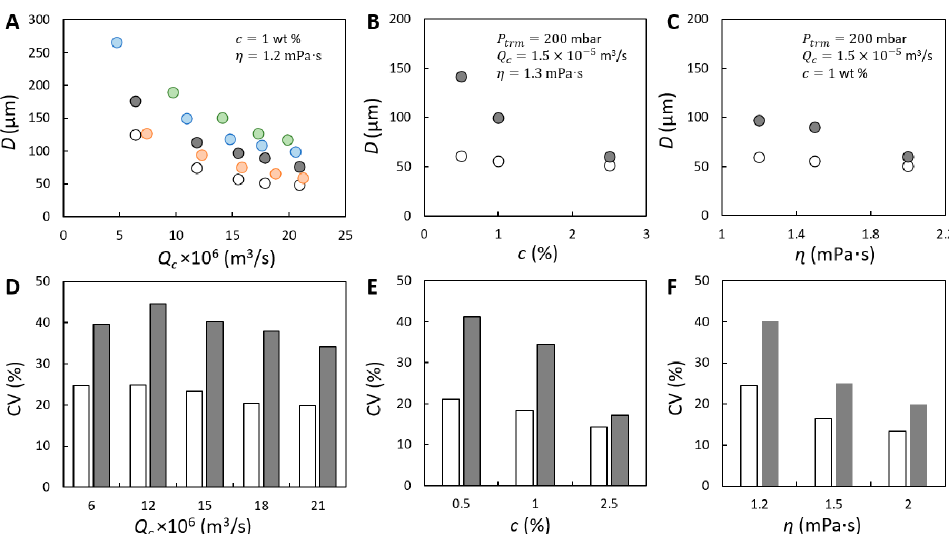
Figure 5. The size and size distribution of coalesced, stabilized bubbles. Bubble size ( 𝐷 (cid:3030)(cid:3042)(cid:3028)(cid:3039) , presented with filled circle) under the effects of: ( A ) shear flow; ( B ) protein concentration; ( C ) continuous phase viscosity. In ( A ), the effect of shear flow on 𝐷 (cid:3030)(cid:3042)(cid:3028)(cid:3039) is investigated for 𝑃 (cid:3047)(cid:3045)(cid:3040) equal to 100 ( ), ), 200 ( ), 300 ( ) and 400 ( ) mbar. In ( A – C ), the size of initial bubbles ( 𝐷 (cid:2868) ) measured at 𝑃 (cid:3047)(cid:3045)(cid:3040) = 200 mbar is plotted for comparison and is presented with unfilled circle ( ). Coefficient of variation (CV) corresponding to 𝐷 (cid:2868) and 𝐷 (cid:3030)(cid:3042)(cid:3028)(cid:3039) measured at 𝑃 (cid:3047)(cid:3045)(cid:3040) = 200 mbar shown in ( A – C ) is presented in ( D – F ). The unfilled and filled bars represent the CV of initially formed and coalesced bubbles, re- spectively.